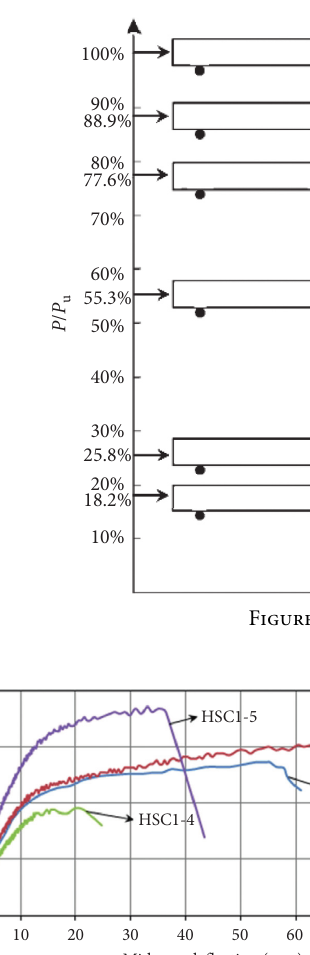
Figure 10: Load versus midspan deflection